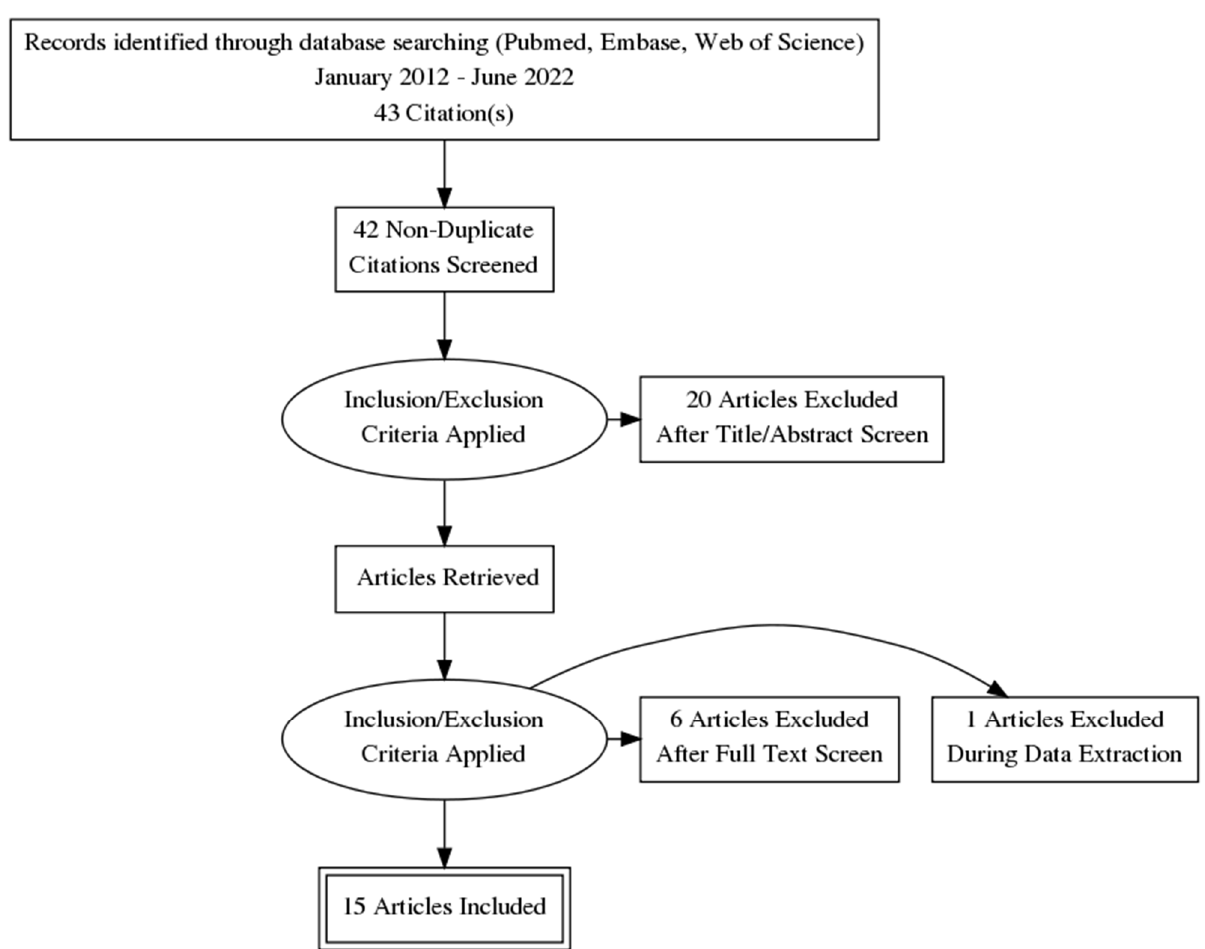
Figure 1. PRISMA flow diagram illustrating the search strategy.